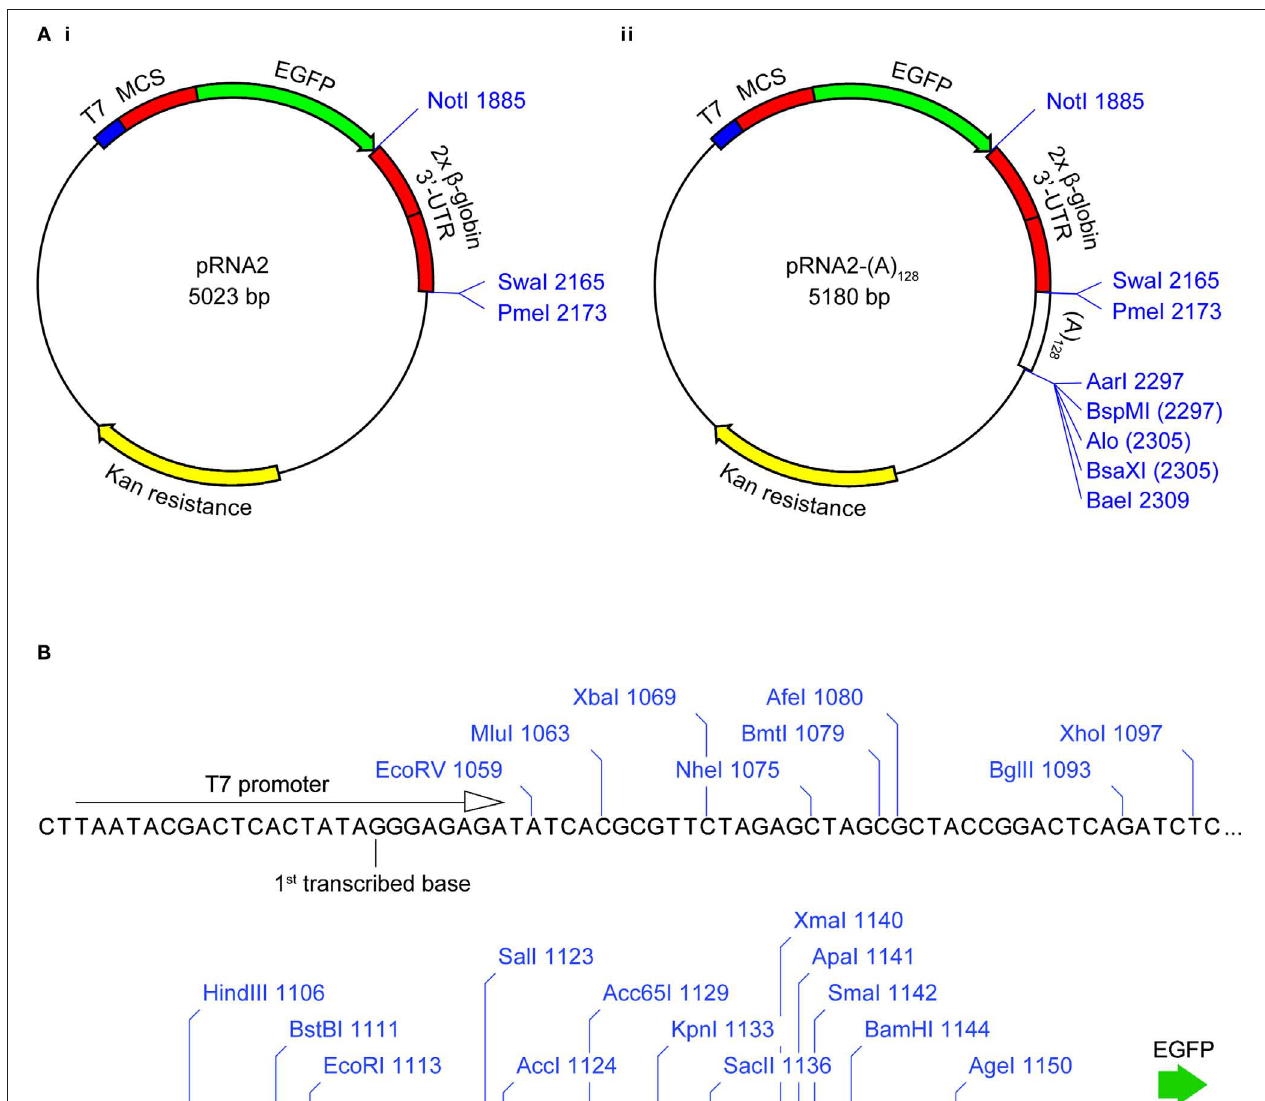
Figure S4 | mrNA template plasmids (A) Maps of the plasmid vectors used templates for mRNA transcription . cDNA of interest is cloned into a multiple cloning sequence (MCS) downstream of a T7 promoter (T7). The plasmids contain an EGFP sequence that can be used for expression of an EGFP fusion protein. EGFP can be removed during cloning by using a 5 ′ site restriction site in the MCS and Not I. pRNA2 (i) can be linearized downstream of the b-globin 3 ′ -UTR sequences using Swa I or Pme I. This vector requires enzymatic polyadenylation. (ii)